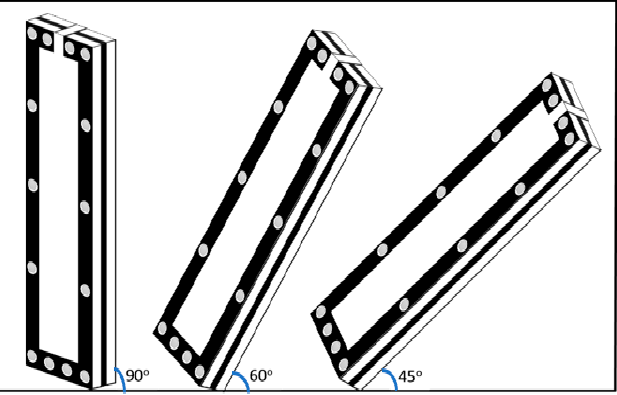
settling velocity at different fracture orientations as a function of the proppant sizes and fracture fluid concentrations. Figure 17. Effect of fracture angulation on the settling velocity of spherical particles.